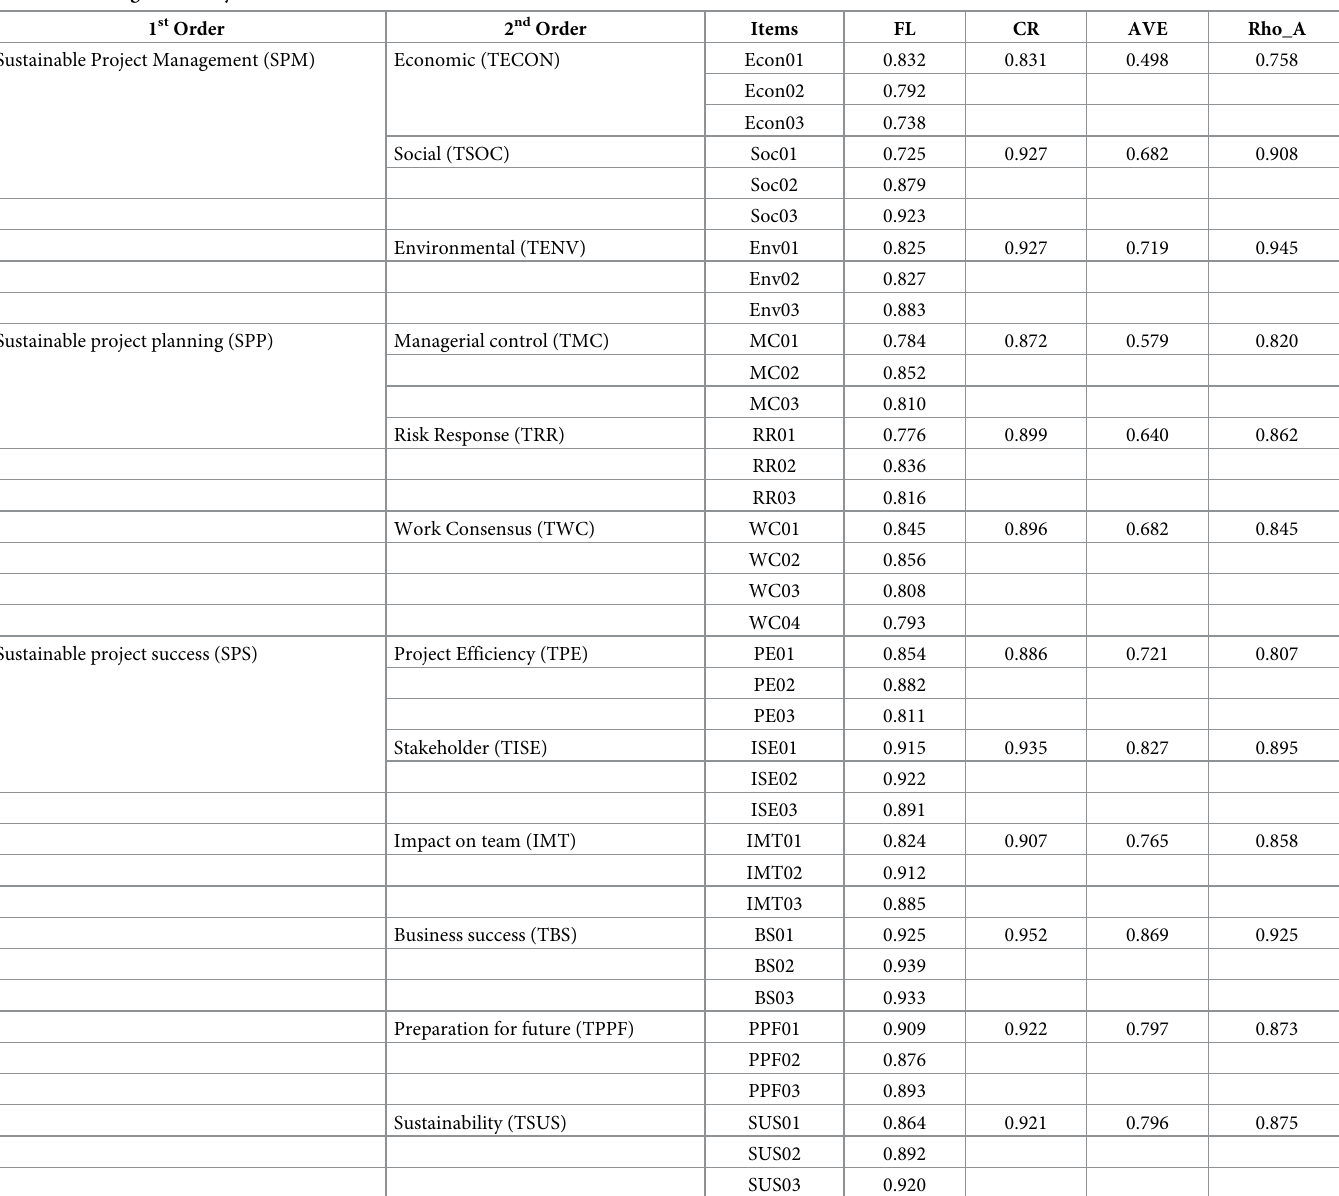
Table 3. Convergent